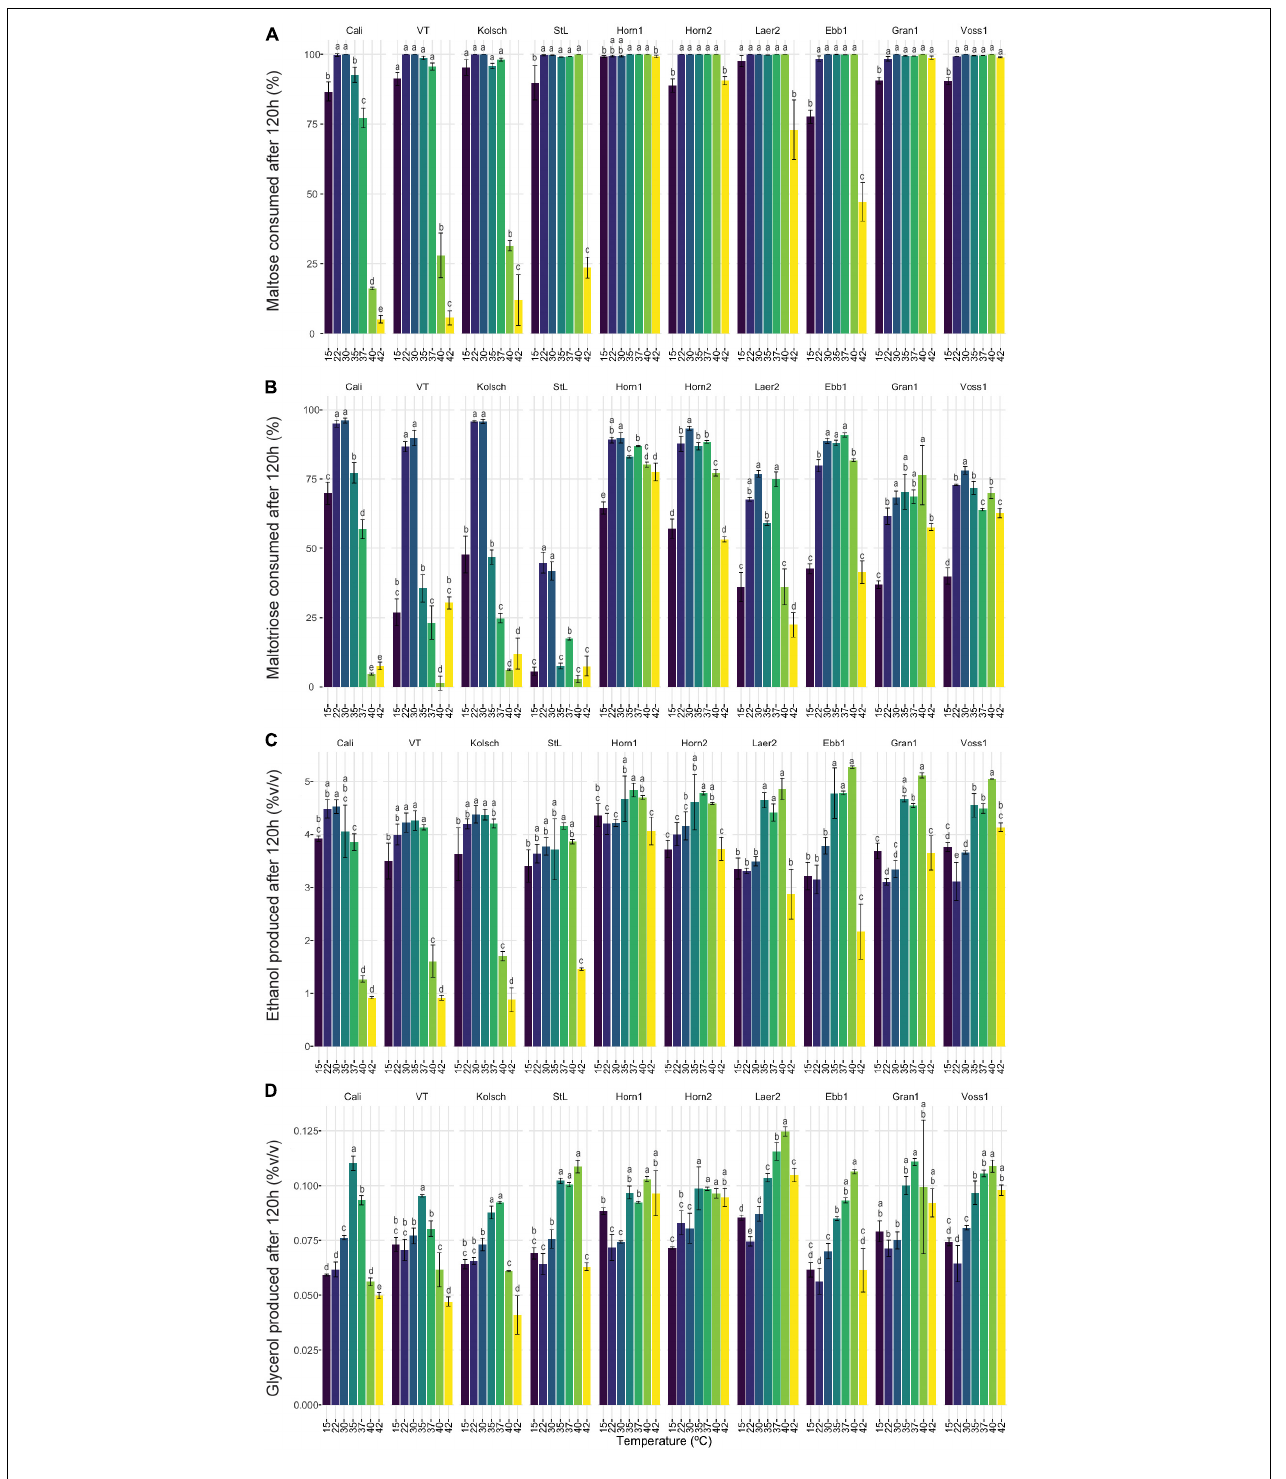
FIGURE 7 | The sugar metabolisms of kveik strains vary in a temperature-dependent manner. The data generated in Figure 6 were reorganized to present the temperature-dependent (A) maltose and (B) maltotriose consumption, and (C) ethanol and (D) glycerol production by each of the indicated strains at 120 h of fermentation. Data points represent the mean of biological replicates ( n = 3) and error bars represent the standard deviation. Data was subjected to one-way ANOVA followed by Tukey’s HSD analysis of the mean sugar consumption and metabolite production between strains for each timepoint and strain (Concentration ∼ Temperature). Mean values assigned with a common letter are not significantly different by the HSD-test at the 5% level of significance within the same strain.